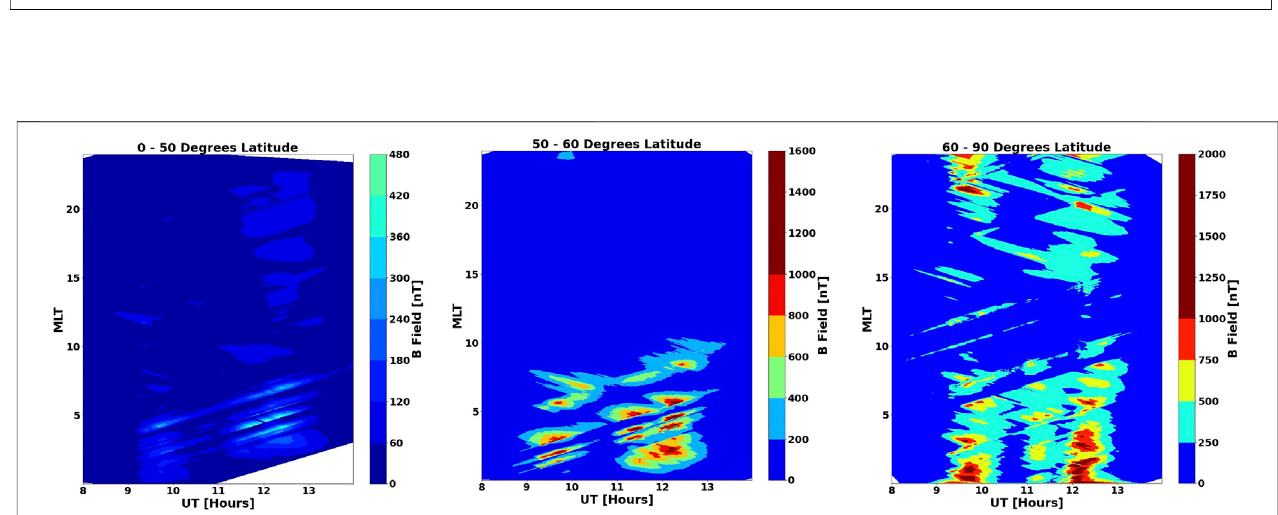
FIGURE 6 | Ground magnetic fi eld north component perturbations as a function of location (MLT) and time (UT) for (A) low, (B) mid, and (C) high latitudes using SuperMAG data. Note that each plot is on the same color scale, but the colorbar indicates the range of values within the plot.